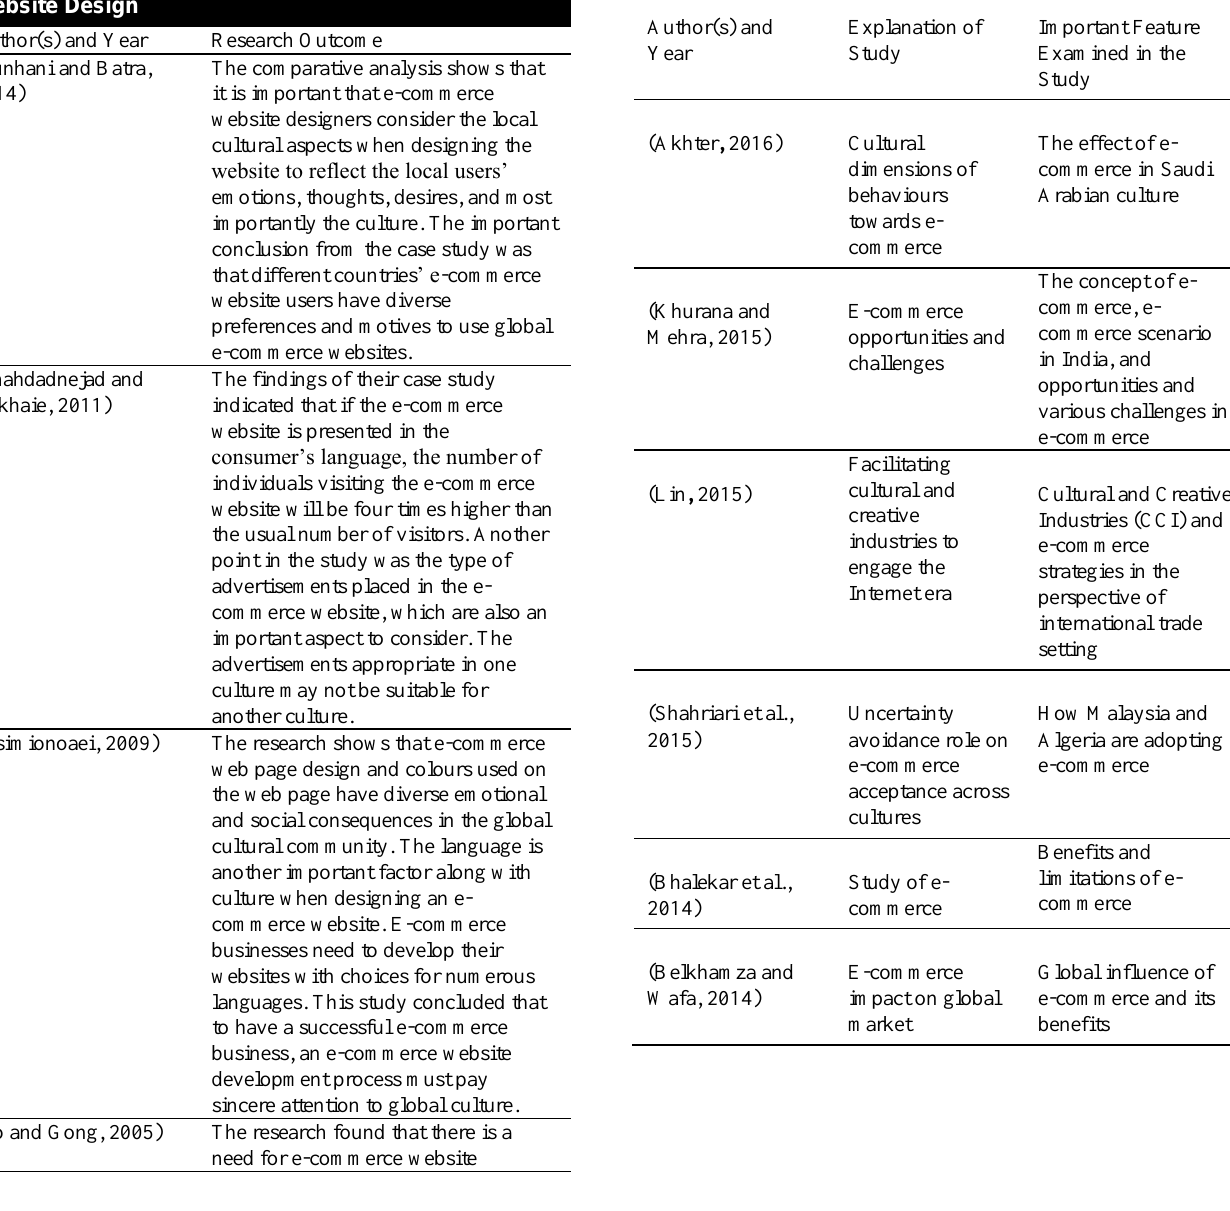
Table 3: A Summary of Selected Studies in Culture,